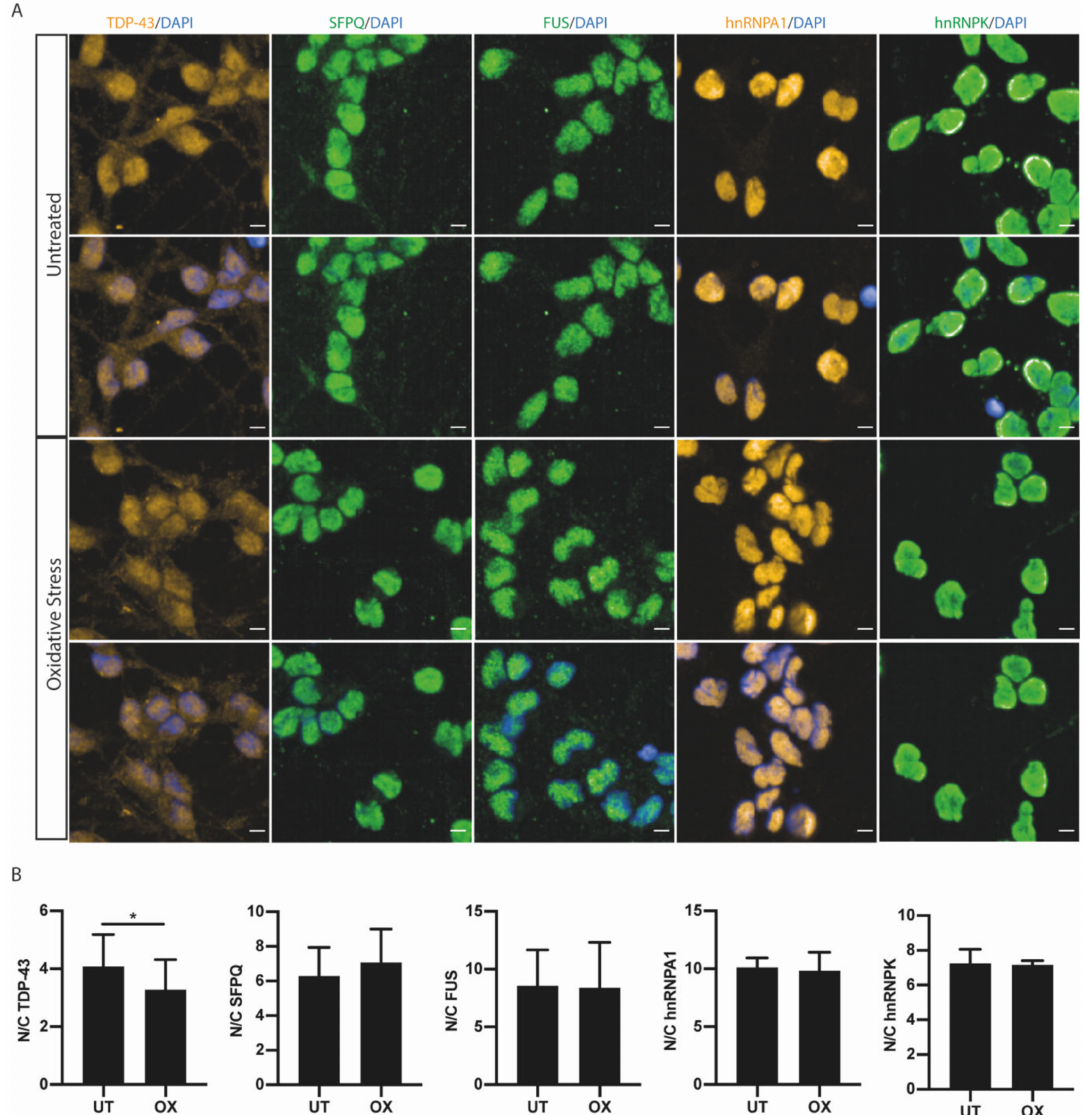
Figure 4. Oxidative stress causes stress-specific changes in TDP-43 nucleocytoplasmic distribution. ( A ) Representative images of TDP-43, SFPQ, FUS, hnRNPA1 and hnRNPK in iPSC-derived motor neurons in untreated and treated with 0.05 mM sodium arsenite for 1 h to stimulate oxidative stress. Scale bars = 5 µ m. ( B ) Individual cell quantification of the nuclear / cytoplasmic ratio identified a significant loss of the nuclear / cytoplasmic ratio in TDP-43 with oxidative stress, with a small increase in the nuclear / cytoplasmic ratio for SFPQ, but no e ff ect on FUS, hnRNPK or hnRNPA1. Data shown are mean nuclear / cytoplasmic ratios ( ± SD) per well from 3 control lines from > 8000 cells for TDP-43, SFPQ and FUS and > 3500 cells for hnRNPA1 and hnRNPK. p -value from unpaired t -test; * = p <